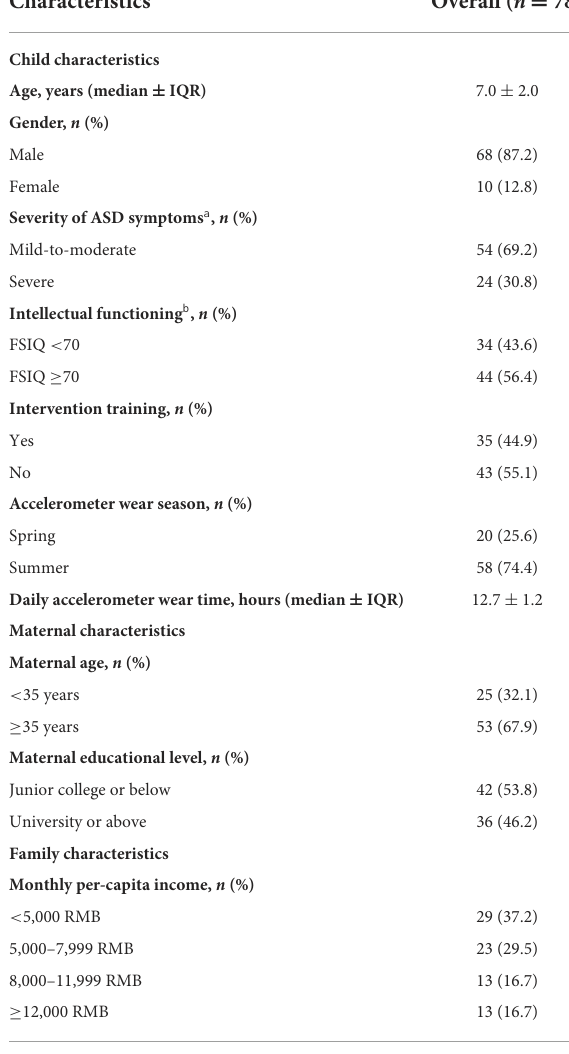
TABLE 1 Descriptive characteristics of the participants, their mothers and